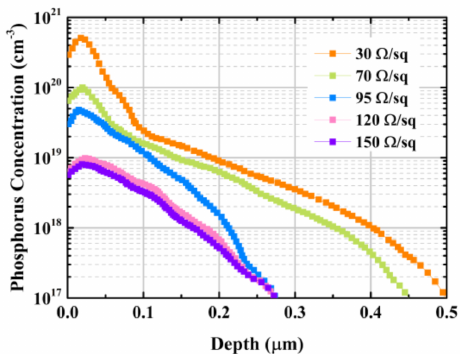
Figure 7. Electrochemical capacitance-voltage (ECV) profiles of front side phosphorus di ff usion layers in the fabricated IBC solar cells; the sheet resistance was determined by four-point probe